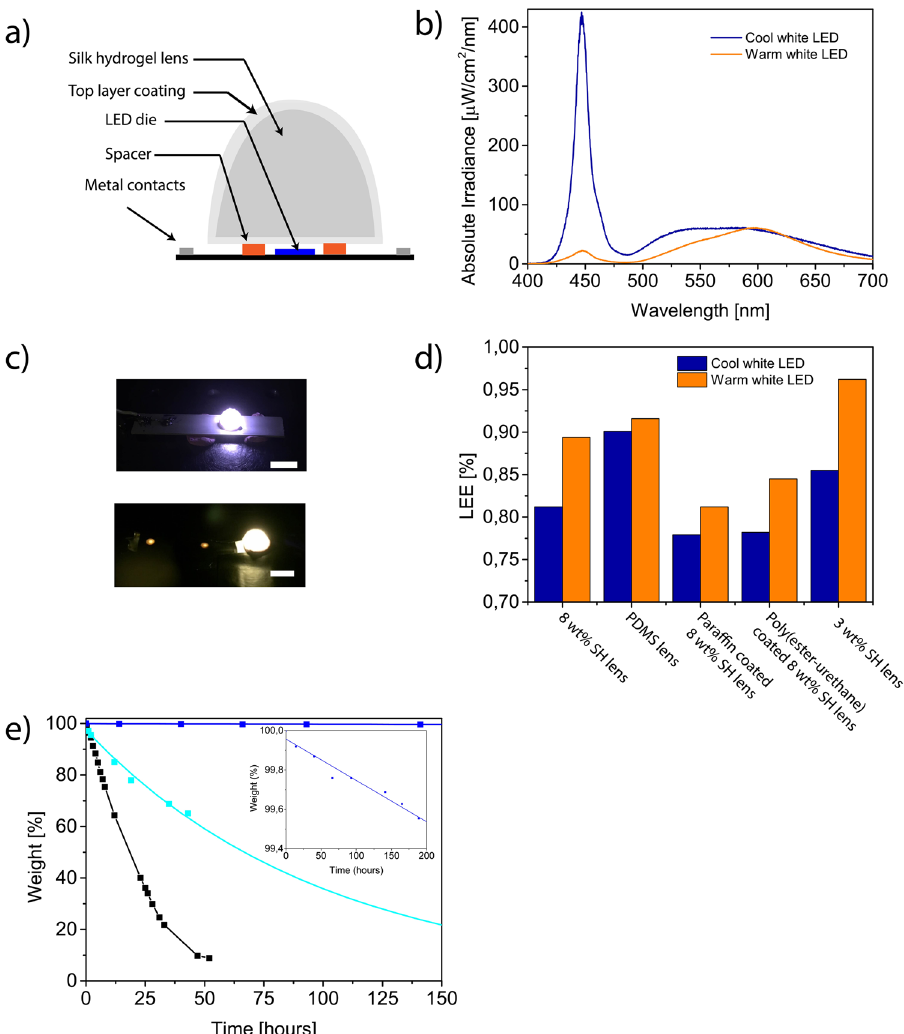
Figure 4. Light extraction efficiency and stability of biomaterial lenses. ( a ) Schematic of silk hydrogel with biopolymer layer coating. ( b ) Absolute irradiance of cool and warm white LED. ( c ) Photographs of 8 wt% silk hydrogel lens on a cool white LED (top) and on a warm white LED (bottom). Scale bar, 1 cm. ( d ) Light extraction efficiency (LEE) of silk hydrogel (SH) lenses with and without top coating, and PDMS lens on cool and warm white LEDs. ( e ) Weight decay of silk hydrogel lens. Black line: sole silk hydrogel lens, cyan line: 8 wt% silk hydrogel lens with poly(ester-urethane) coating, blue line: 8 wt% silk hydrogel lens with paraffin wax coating. Inset: zoomed weight decay of silk hydrogel lens with paraffin wax coating.